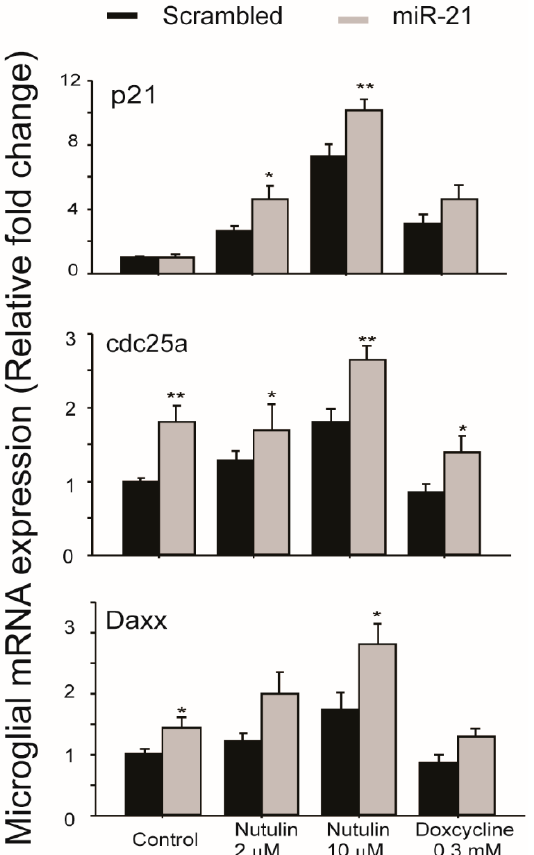
Figure 4. Microglial gene expression after transfection with miR-21 mimics. Cells were transfected with either miR-21 mimics or control scrambled miRNA. At 2 days after transfection, cells were treated with either nutulin or doxycycline at the indicated concentrations for 16 h. Quantitative RT-PCR analyses were performed to measure the relative levels of gene expression downstream of the p53 pathway. Data presented are the average of 4 independent experiments (mean ± sem; * p < 0.05; ** p < 0.01).